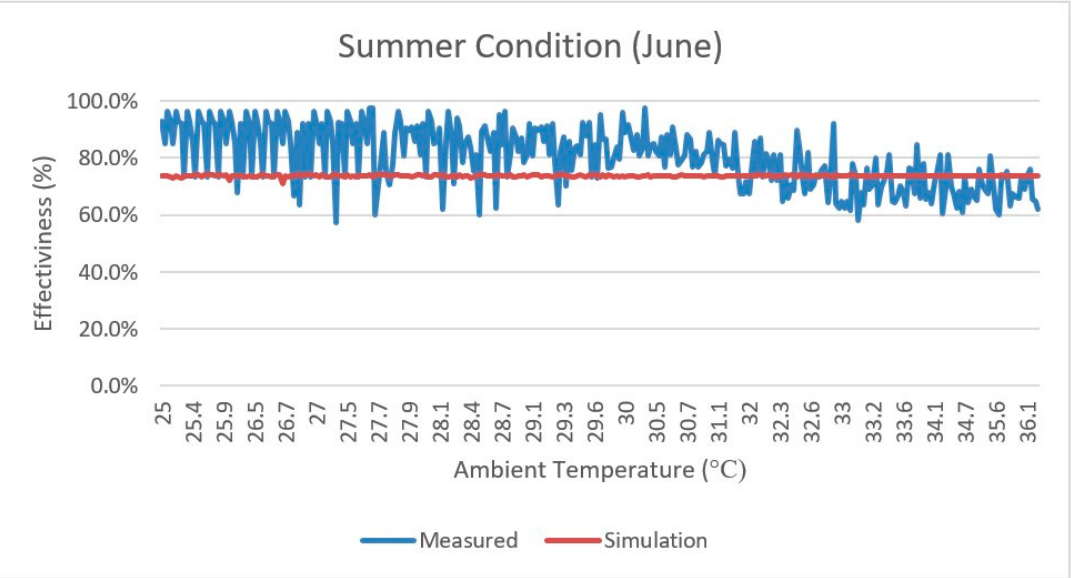
Figure 9. The measured and simulated sensible effectiveness values in summer.